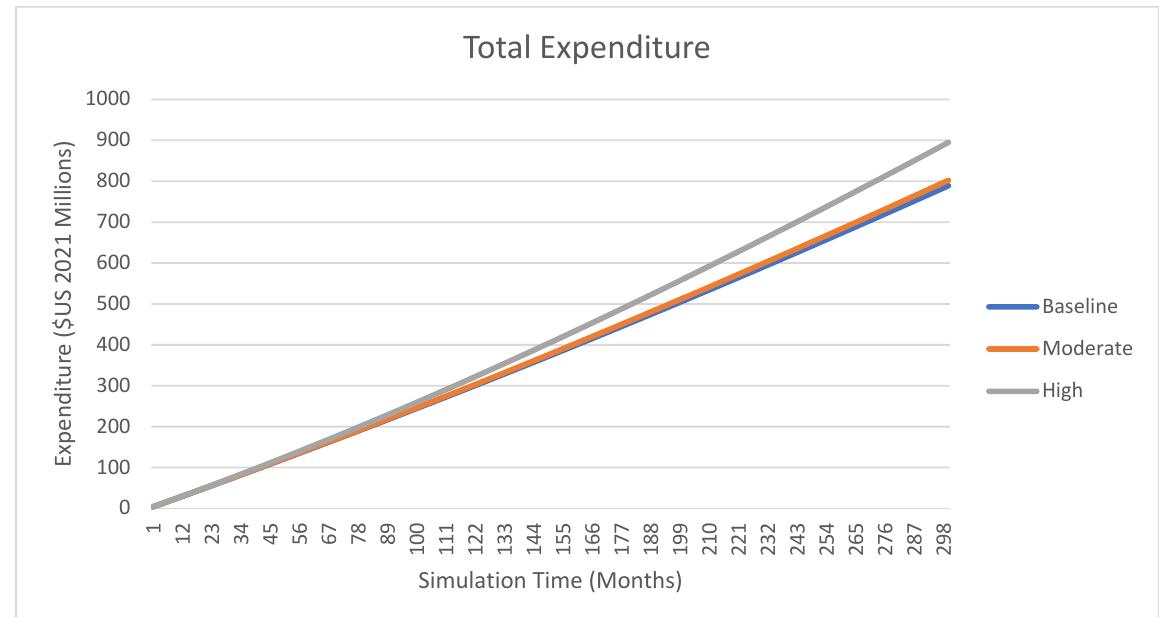
Figure 4. Sensitivity of the model to grid electricity tariff.